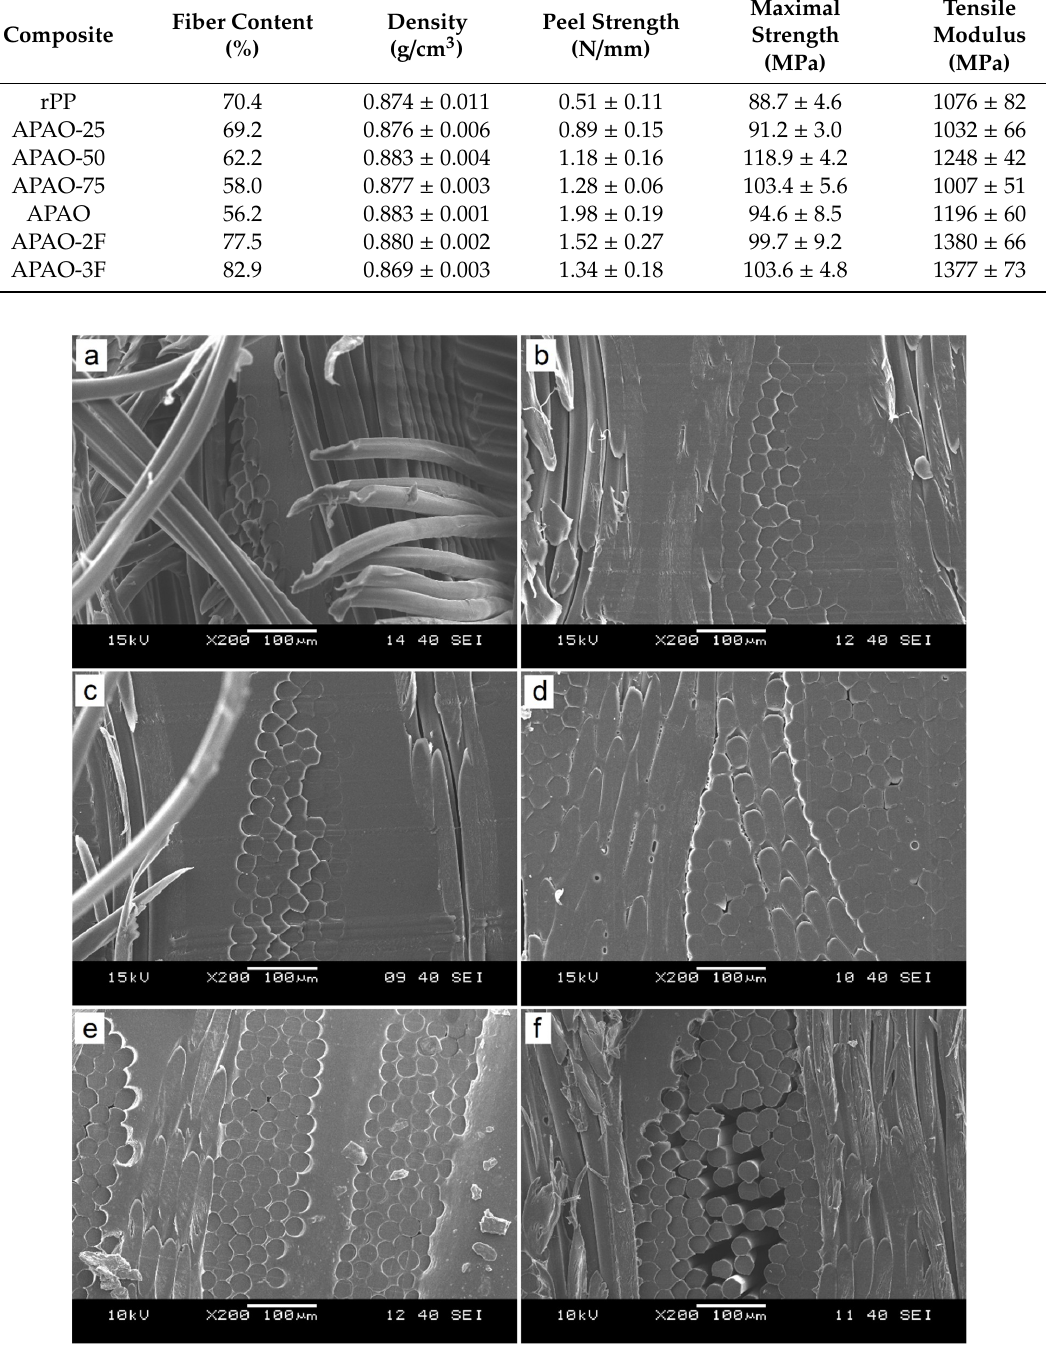
Figure 5. Scanning electron microscopic images of ( a ) rPP, ( b ) APAO-50, ( c ) APAO-75, ( d ) APAO, ( e ) APAO-2F and ( f ) APAO-3F. ( e ) APAO-2F and ( f )